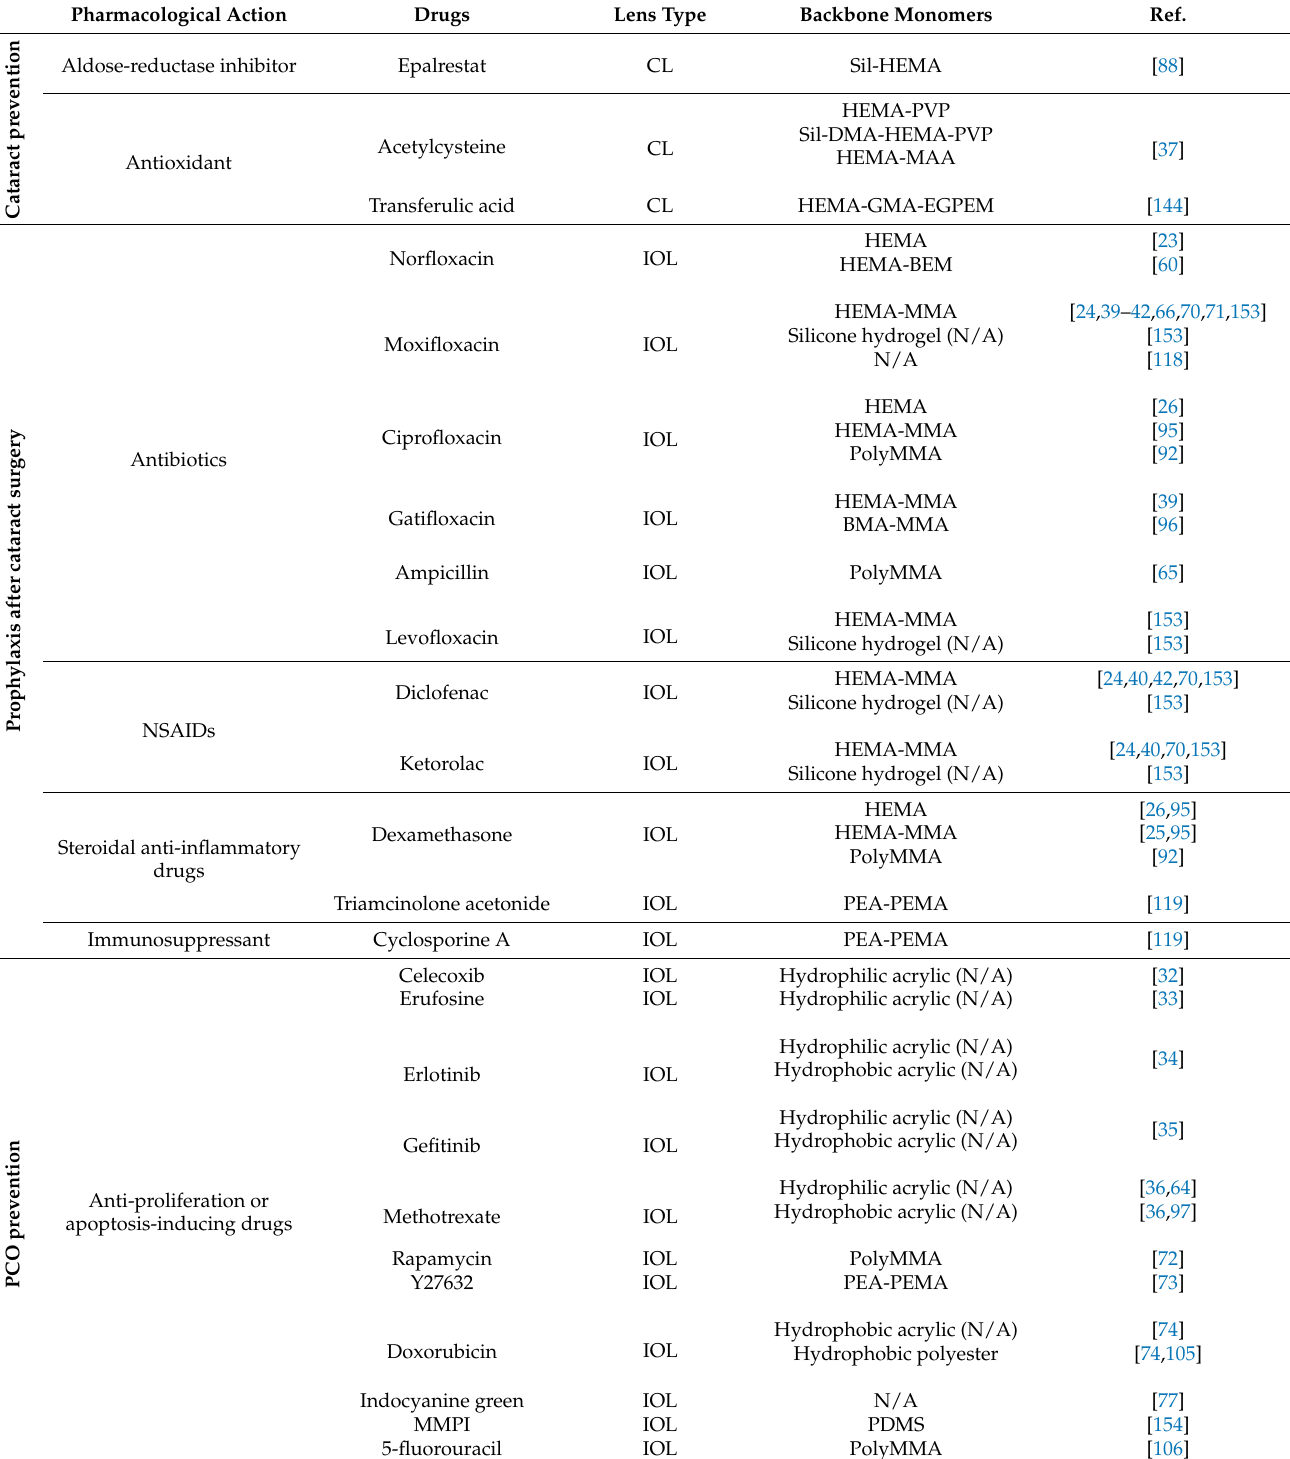
Table 2. Therapeutic ophthalmic lenses developed between 2010 and 2020 suitable for the prevention of cataract and pathologies that are associated to cataract